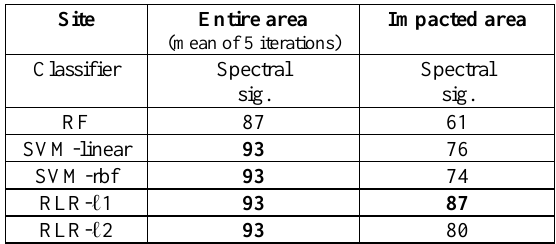
Table 5 . Overall accuracy of different classifiers for different HS